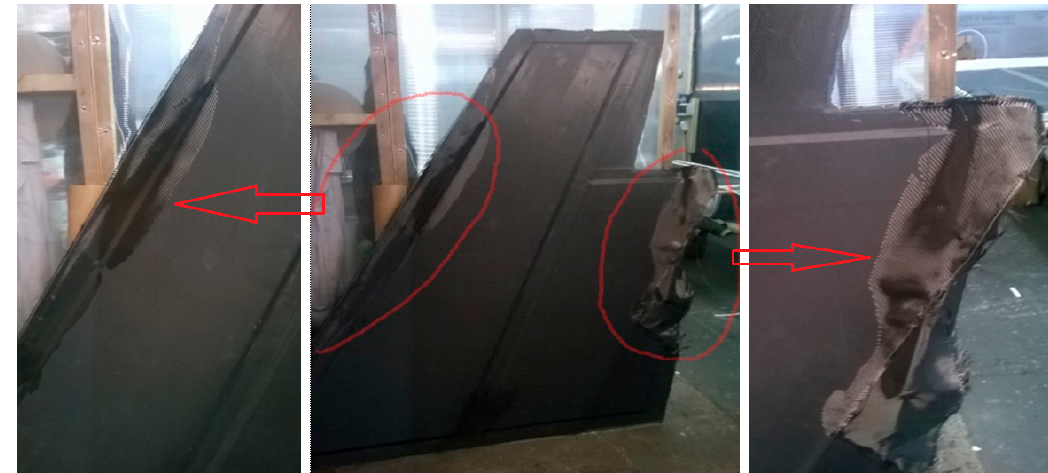
Figure 8. The non-impregnated edges of the cured tail panel in its corners ( right ) and on the periphery ( left ). The full view of the ready defective part is shown in the center photo.